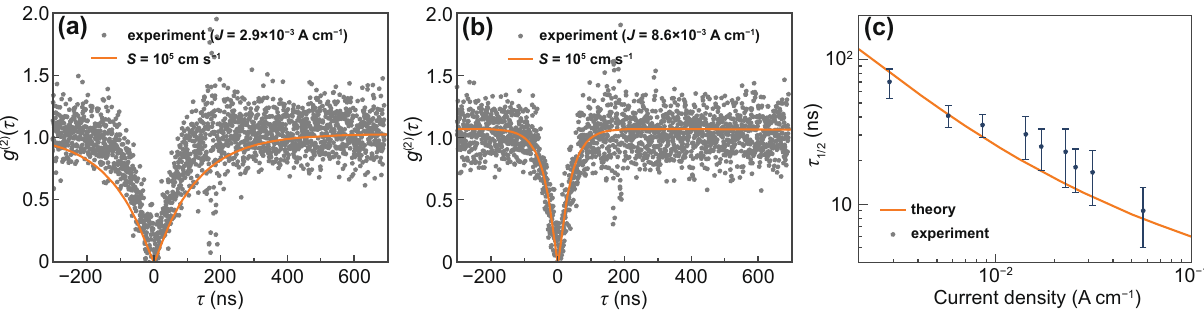
Fig. 5 a, b Theoretical g (2) functions simulated at c p− = 1.5 × 10 −7 cm 3 s −1 and experimental g (2) curves retrieved from Ref. [24] at current densi- ties of 2.9 ( a ) and 8.6 ( b ) mA cm −1 . c Half-rise time of the experimentally measured g (2) function and fit obtained using numerical simulations of the 4H-SiC single-photon emitting diode. In all panels, S = 10 5 cm s −1 , c p− = 1.5 × 10 −7 cm 3 s −1 , and c n0 = 6.9 × 10 −9 cm 3 s −1 for the theoretical